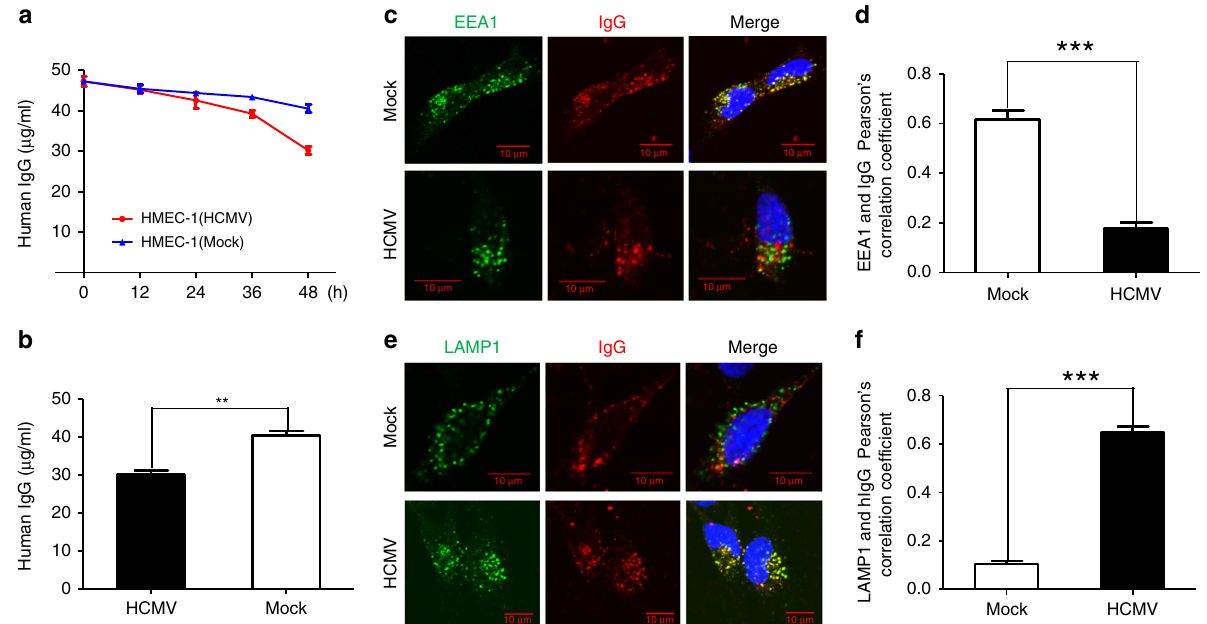
Fig. 9 HCMV infection increases IgG catabolism in human endothelial cells. a , b HEMC-1 cells (5 × 10 5 /2 ml) were grown in complete medium with 5% FBS with ultra-low IgG. After cells were infected with 5 MOI of HCMV or mock-infected for 48 h, they were incubated with 50 μ g/ml human IgG for 48 h at 37 °C. After washing, the cells were incubated at 37 °C. During the incubation, 50 μ l of supernatant was sampled at 0, 12, 24, 36, and 48 h and the IgG concentration in each sample was measured by ELISA ( a ). At 48 h, the IgG concentration in the medium from the HCMV-infected and mock-infected cells was analyzed by t -test ( b ). ** P < 0.01 by Student ’ s t -test. Error bars represented mean ± SEM of three independent repeats. c – f To visualize human IgG traf fi cking inside infected HEMC-1 (5 × 10 4 ) cells, cells were infected with 5 MOI of HCMV for 48 h and incubated with 250 μ g/ml human IgG for 1 h at 37 °C. After washing, cells were incubated in complete medium without IgG for an additional 1 h, then fi xed and stained for co-localization of human IgG with the early endosomal marker EEA1 ( c ) or lysosomal marker LAMP-1 ( e ). Scale bar: 10 μ m. For Pearson ’ s correlation coef fi ciency measurement, ten microscopic fi elds, each of which contained at least ten cells, were measured for correlation coef fi ciency rate ( d , f ). *** P < 0.001 by Student ’ s t -test. Error bars represented mean ± SEM of three independent